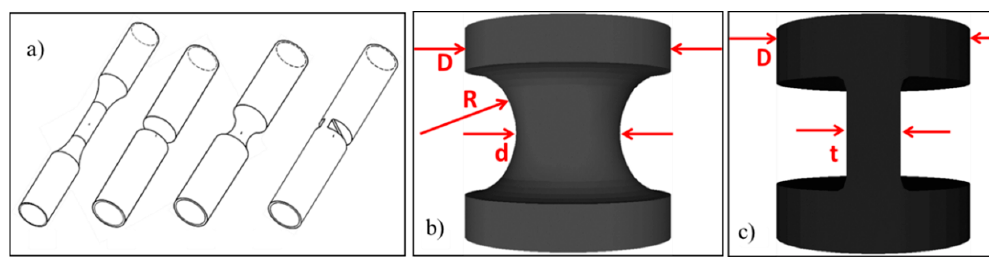
Figure 8. ( a ) 3D sketch of four specimen shapes: R0, R1, R2, and PE (from left to right). ( b , c ) A representation of the main dimensions of four specimen’s geometry that depicts di ff erent stress states. The denotations in ( b , c ) are expressed in Table 7. Reproduced from Reference [1], with permission from Elsevier,